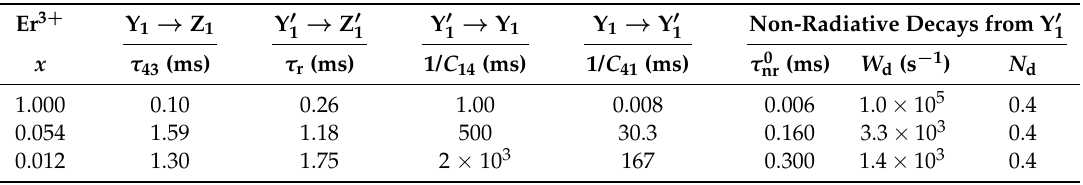
Table 3. The set of parameters used in the rate equation